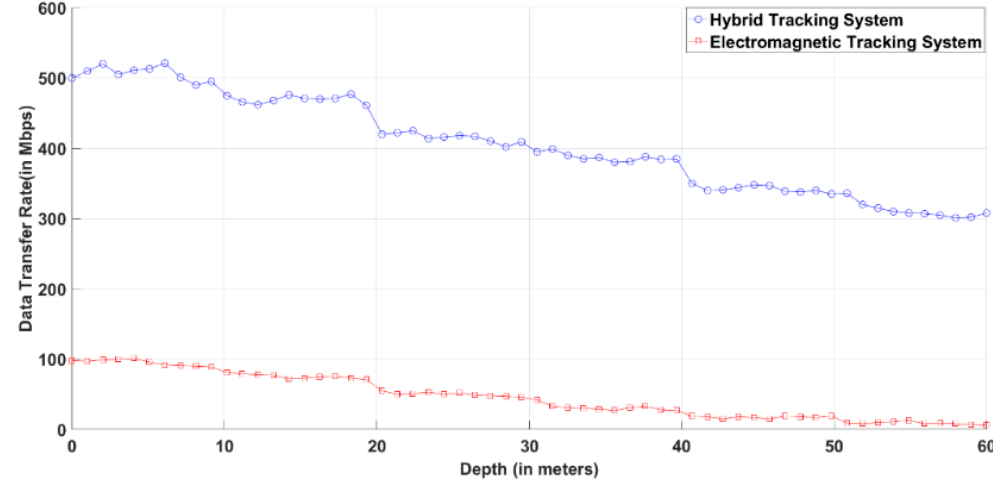
Figure 14 represents the data rate of the electromagnetic tracker and hybrid tracker. The data rate decreases in the case of both electromagnetic tracker and hybrid tracker as the depth of the seawater increases due to turbidity and dirt in the seawater. However, the decrease in data transfer rate is significantly less in the case of a hybrid tracking system as compared to the electromagnetic tracking system alone. The data rate shown in Figure 14 is simulated using Equations (15) and (16).